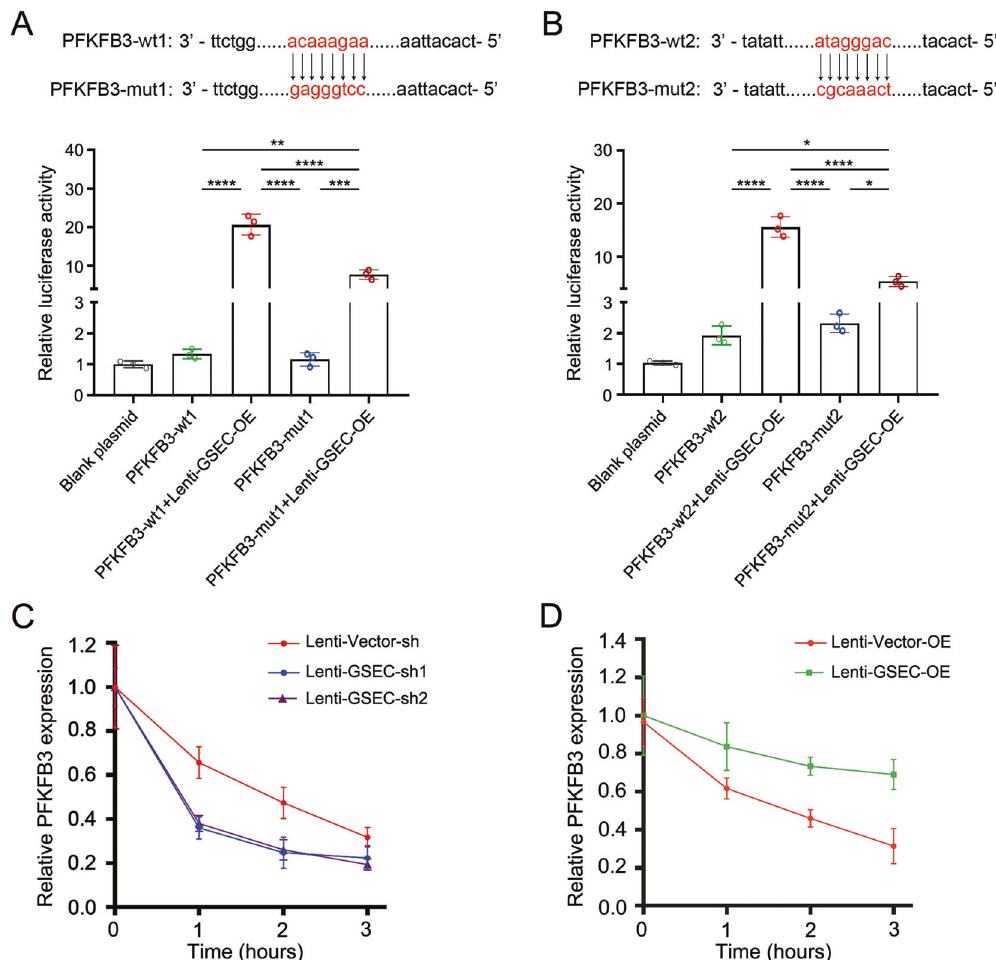
Fig. 5 GSEC was essential for enhancing PFKFB3 mRNA stability. A GSEC positively regulates PFKFB3 transcription through the active site (acaaagaa) of PFKFB3. B GSEC positively regulates PFKFB3 transcription through the active site (ataggac) of PFKFB3. C The stability of